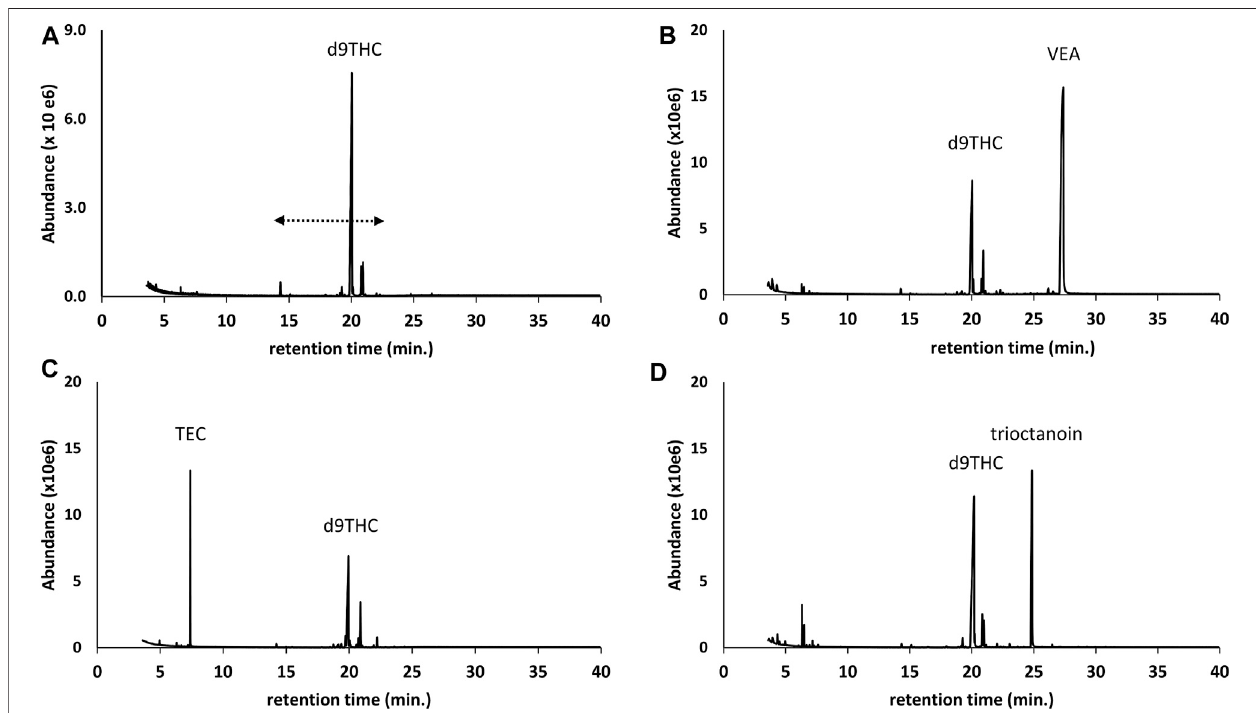
FIGURE 1 | GC-MS chromatograms for d9THC vaping liquids in which no additives were identi fi ed (A) , and for which single compound additives were identi fi ed as follows: vitamin E acetate (VEA) (B) ; triethyl citrate (TEC) (C) ; and trioctanoin (D) . The retention range for the parent cannabinoids is indicated by the dashed double arrow (as shown in Panel 1 A ), and the minor peaks in this range for all chromatograms correspond to other cannabinoids including CBD, CBG, and CBN. The early eluting peaks in Panel 1 (D) (less than 8 min) correspond to terpenes.